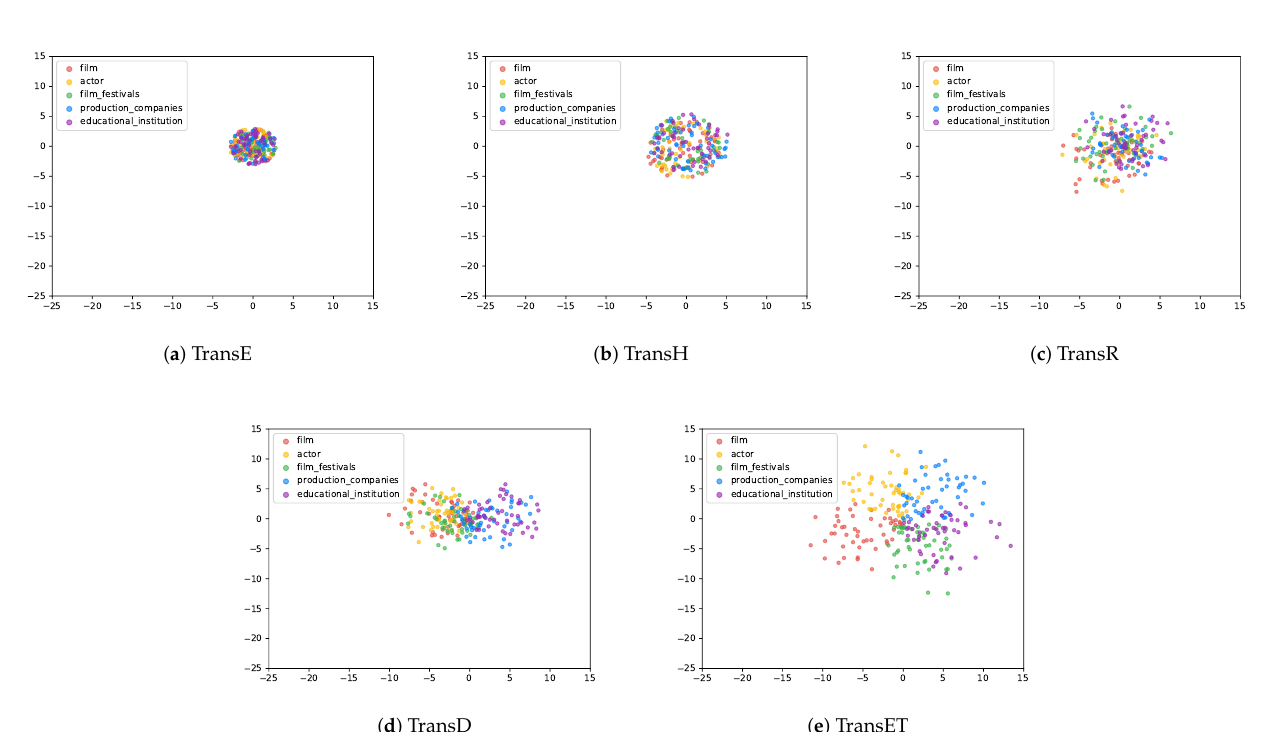
Figure 4. 2D visualization for the embeddings of some tail entities with the same relation and the same head entity.